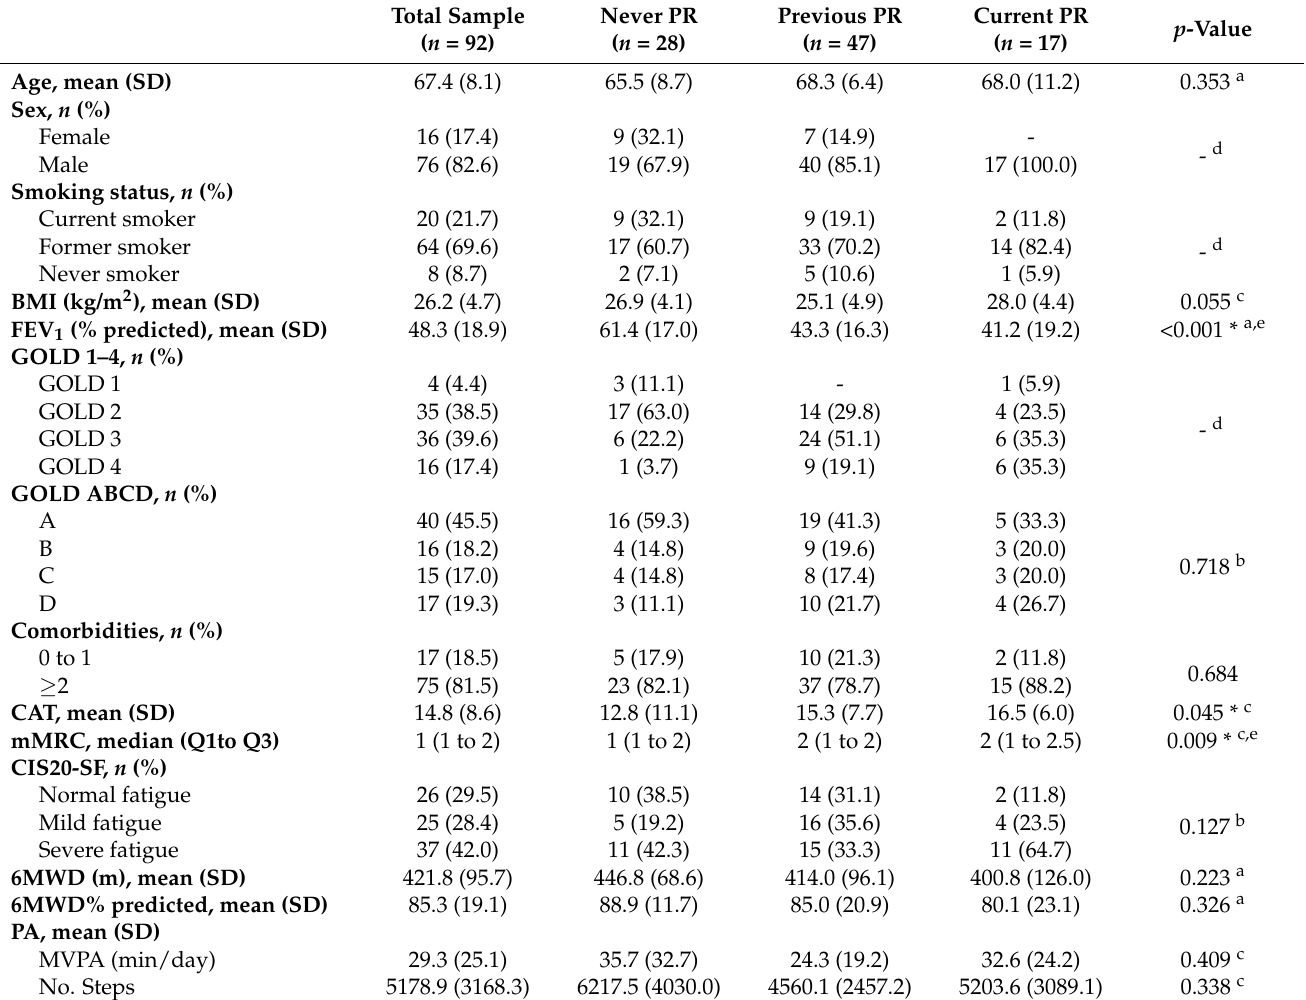
Table 2. Participants’ sociodemographic and clinical characteristics ( n =